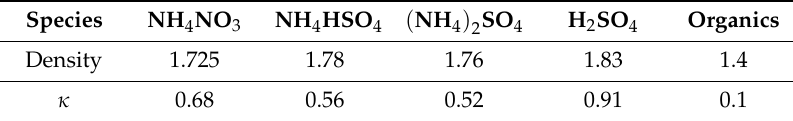
Table 2. The density (in g cm − 3 ) and κ of the selected